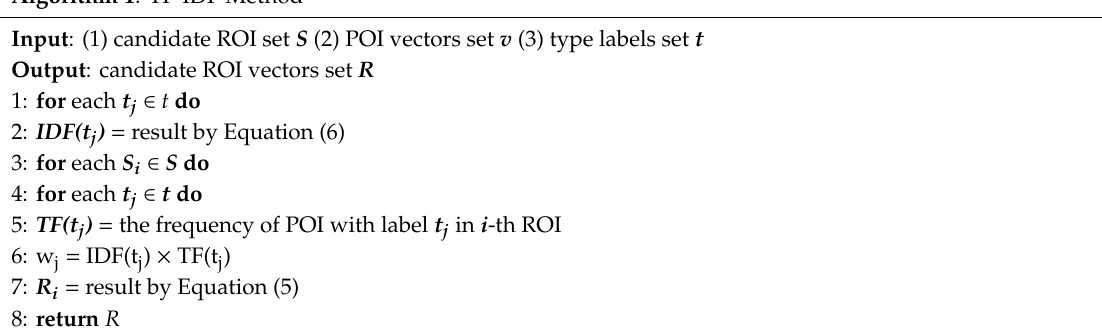
Algorithm 1 : TF-IDF Method